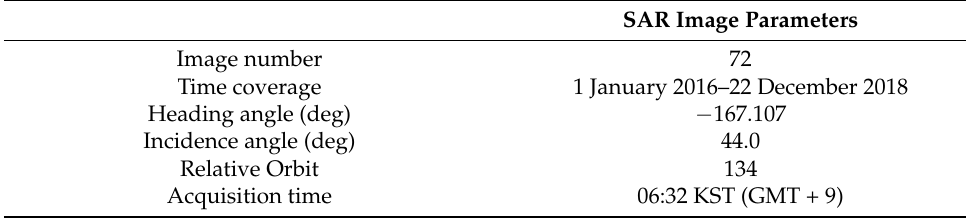
Table 1. Characteristics of employed Sentinel-1 images.